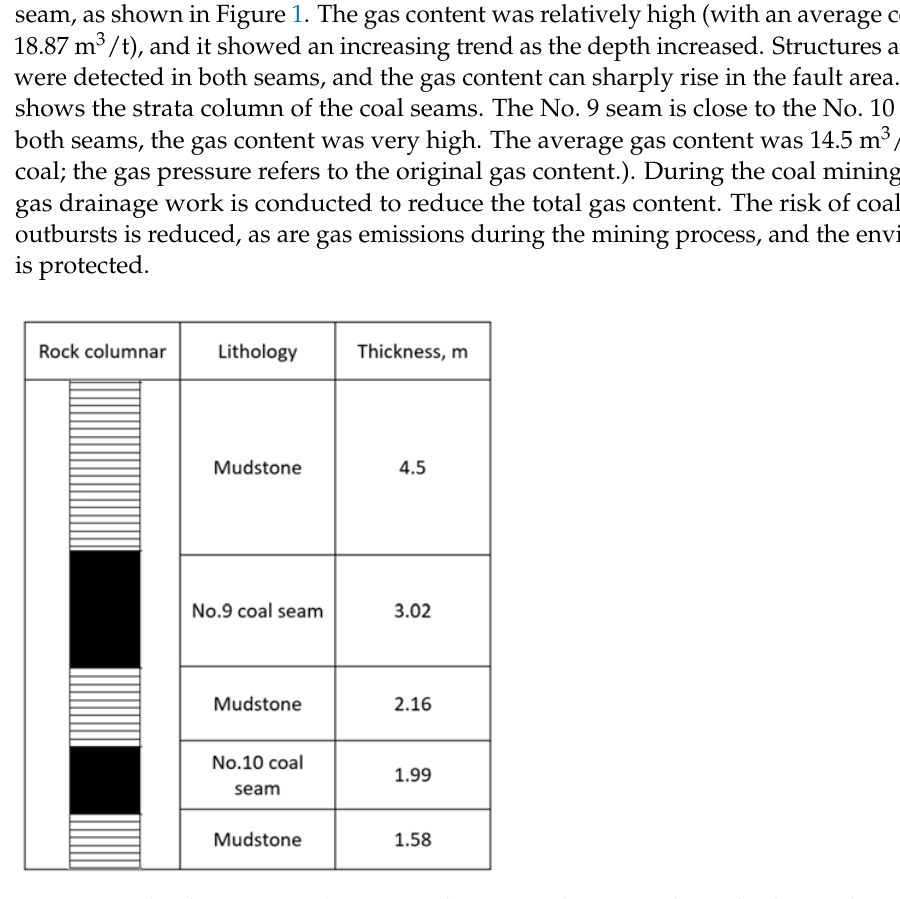
Figure 1. Rock columnar near the No. 9 and No. 10 coal seams in the Wuhushan coal mine.